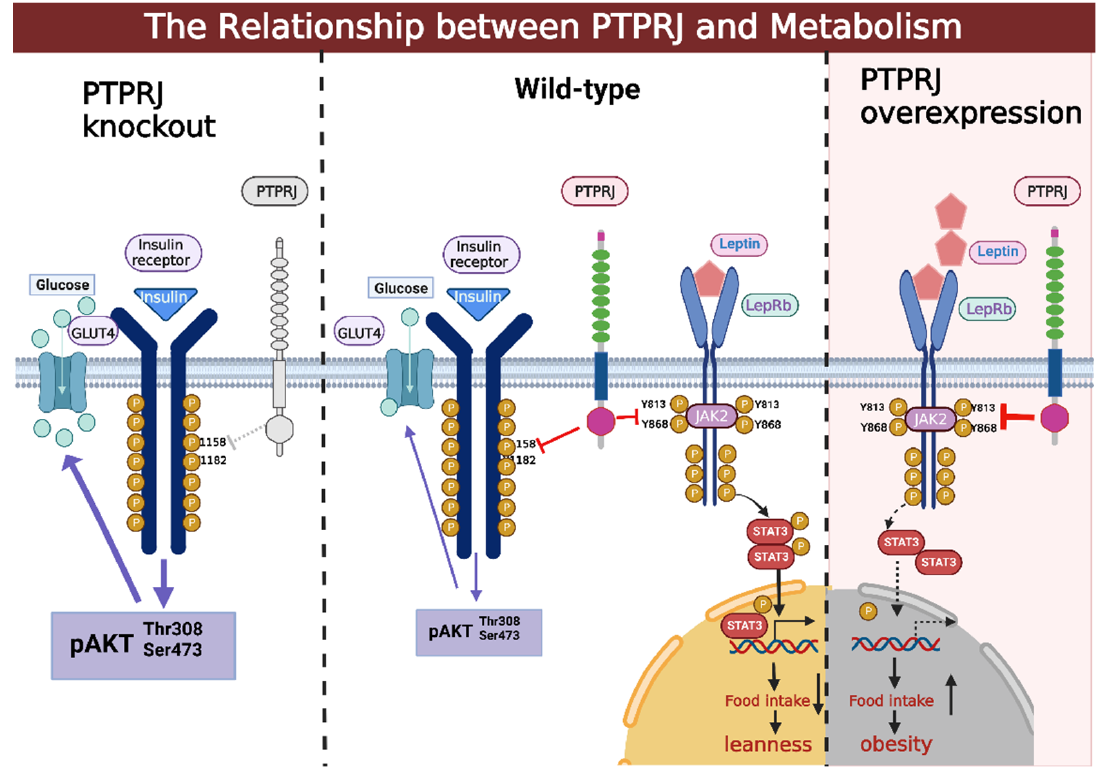
Figure 3. The relationship between PTPRJ and metabolism LepRb dimerizes as a result of leptin binding to the receptor molecule. Following JAK2 autophosphorylation, certain tyrosine residues in